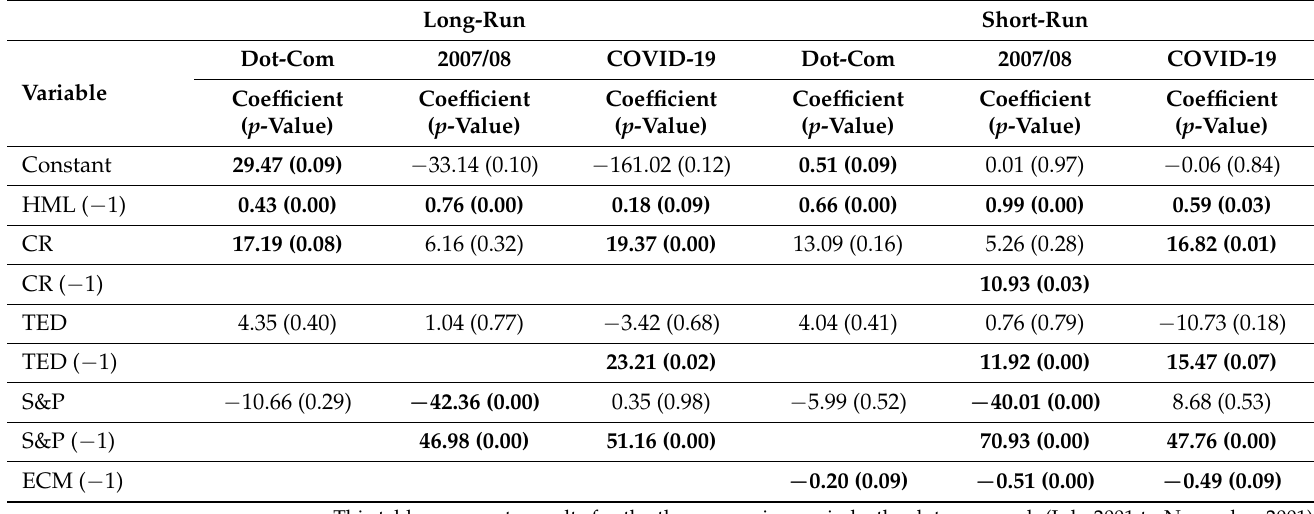
Table 16. Long-run ARDL model and short-run error correction model for HML (Recession).